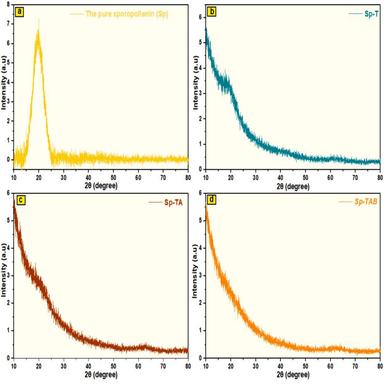
XRD patterns of (a) the pure Sp, (b) Sp-T, (c) Sp-TA and (d) the fluorescent Sp-TAB hybrid material.